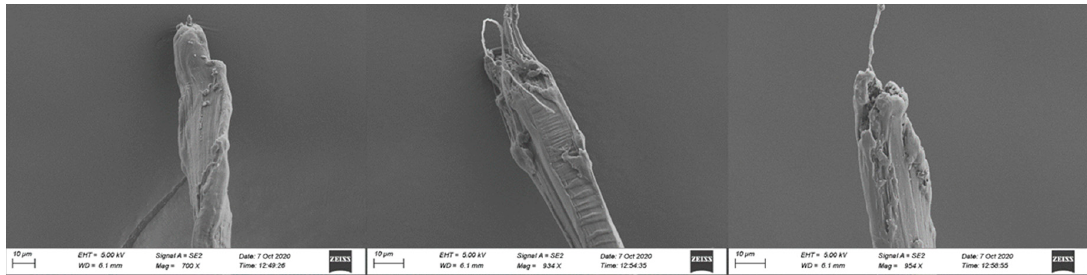
Figure 14. SEM images of fiber fracture surfaces for the 0.3 caliber FSP.